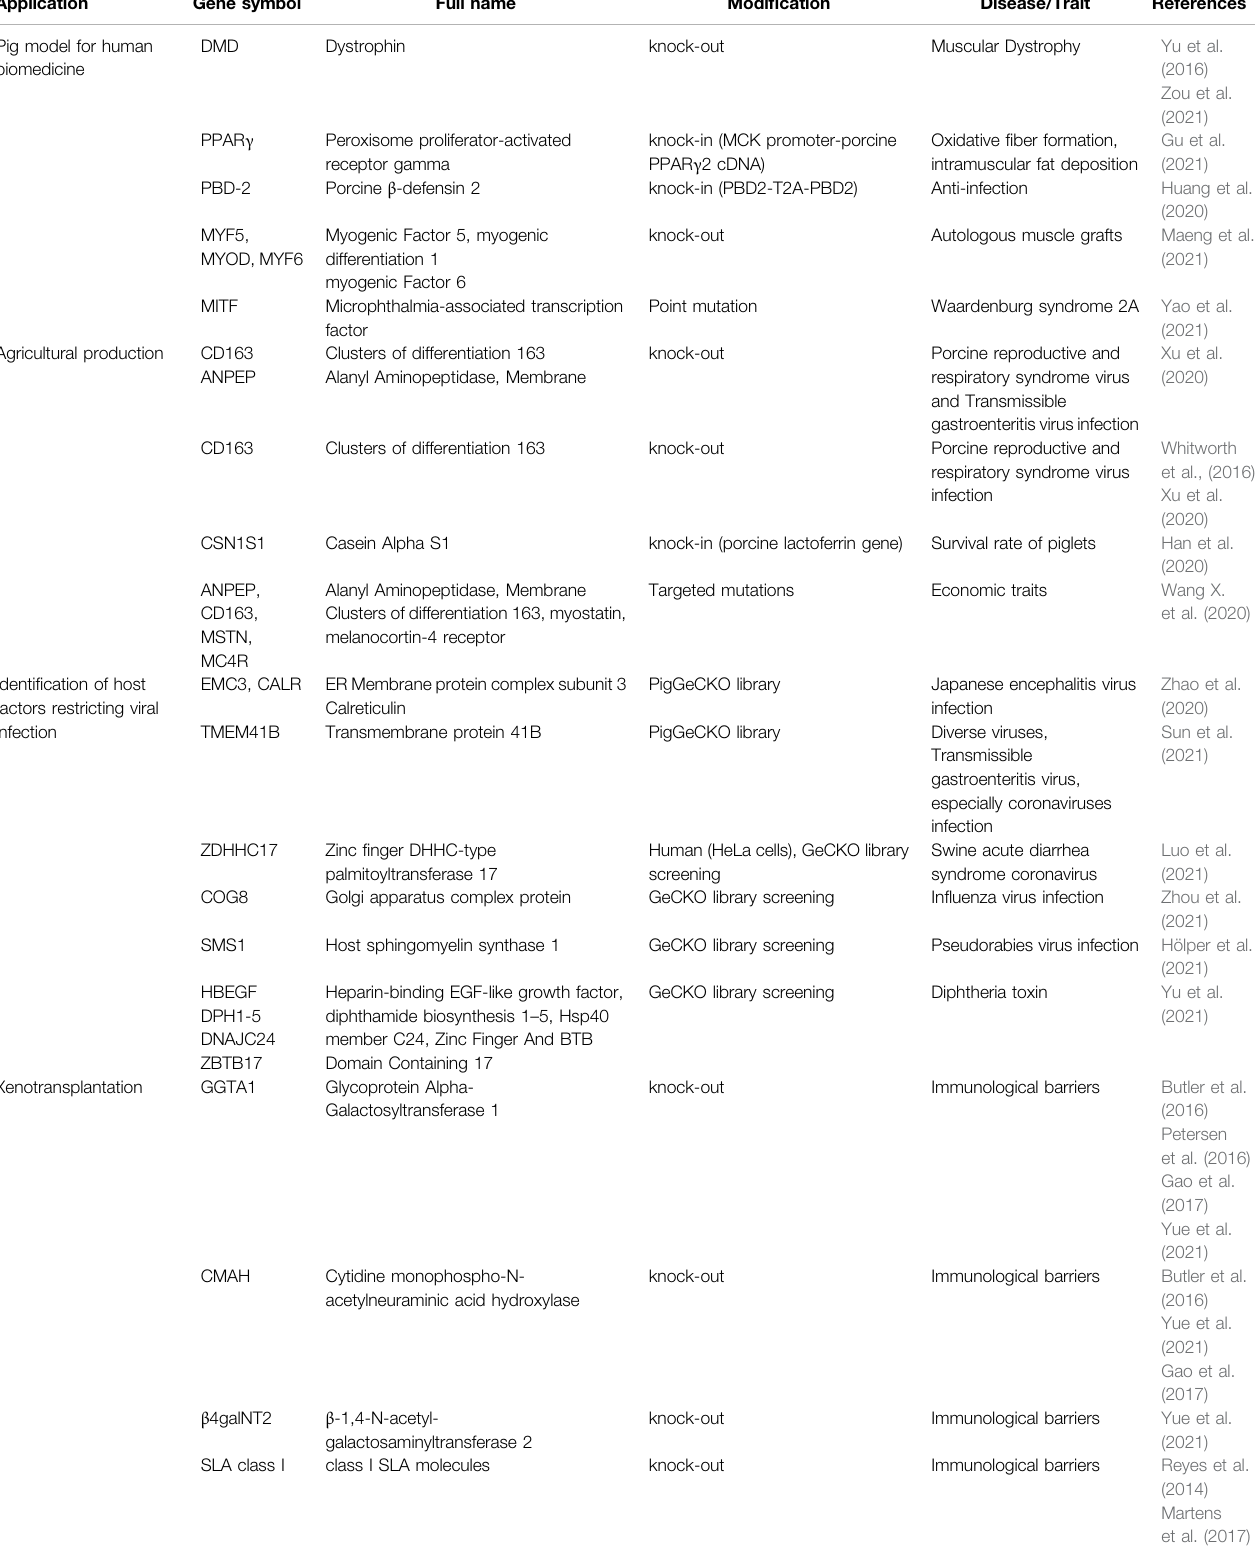
TABLE 1 | Summary of genetic changes introduced into porcine genome by CRISPR